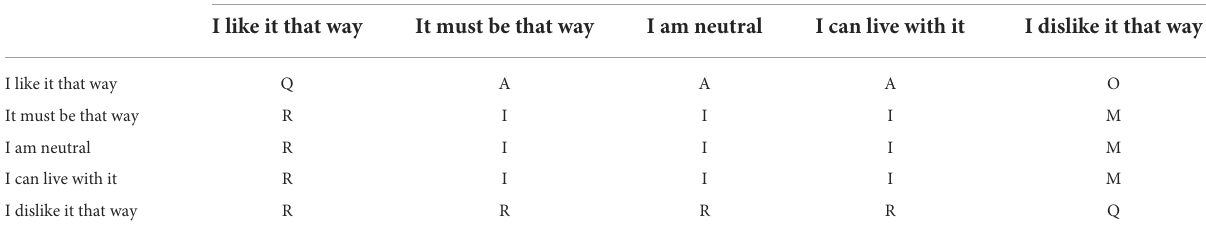
TABLE 2 Kano evaluation table. Functional form